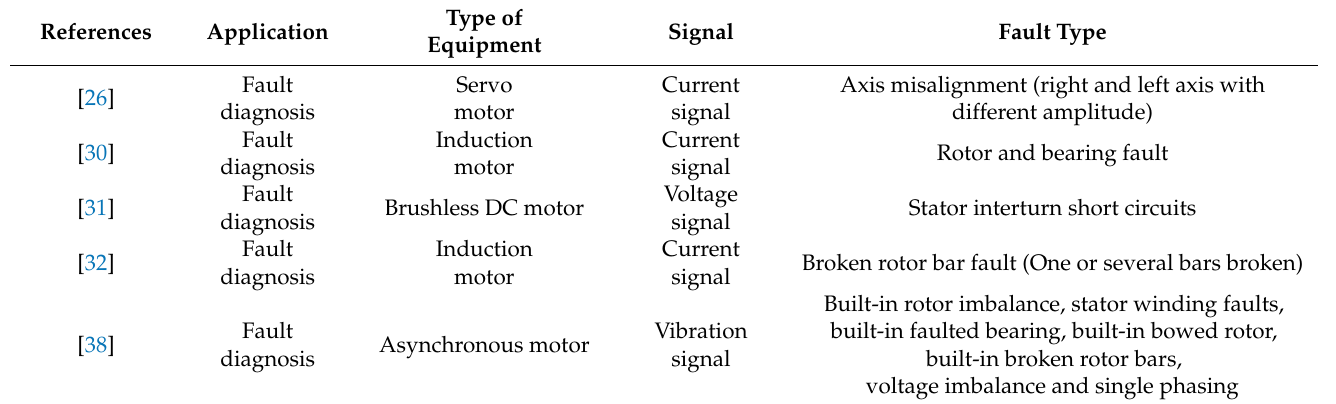
Table 1. Motor condition monitoring using Fourier transform.